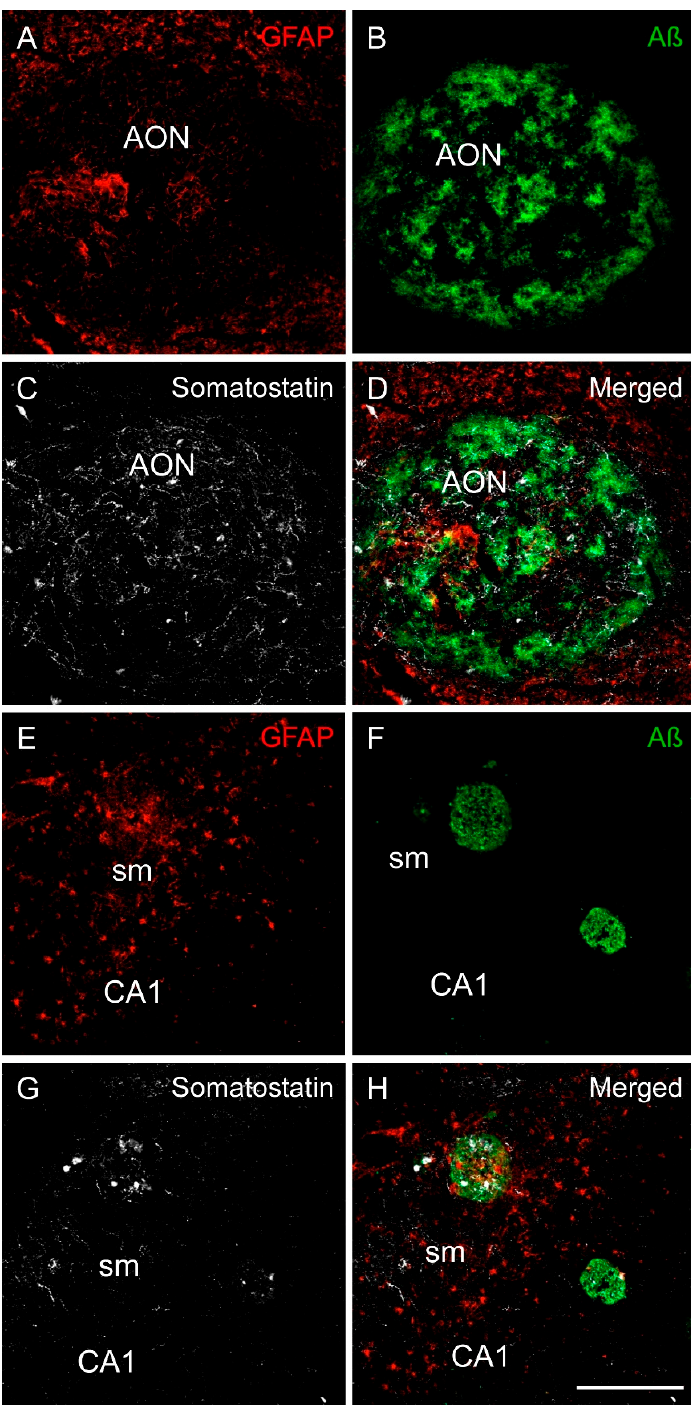
Figure 7. Immunofluorescence staining of somatostatin, amyloid- β and GFAP in the human olfactory limbic systems in AD. Representative images show staining for GFAP (astrocytes in red), amyloid- β (green) and somatostatin (white) in the anterior olfactory nucleus ( A – D ) and in the CA1 region of the hippocampus ( E – H ). In the anterior olfactory nucleus, there were less astrocytes than in the surrounding area ( A ), whereas amyloid- β ( B ) and somatostatin ( C ) were tightly coexpressed ( D ). In the hippocampus, astrocytes were abundant in the molecular layer of CA1 ( E ). In addition, astrocytes, amyloid- β plaques ( F ) and somatostatin ( G ) were commonly coexpressed in this area ( H ). Scale bar A – H 200 µ